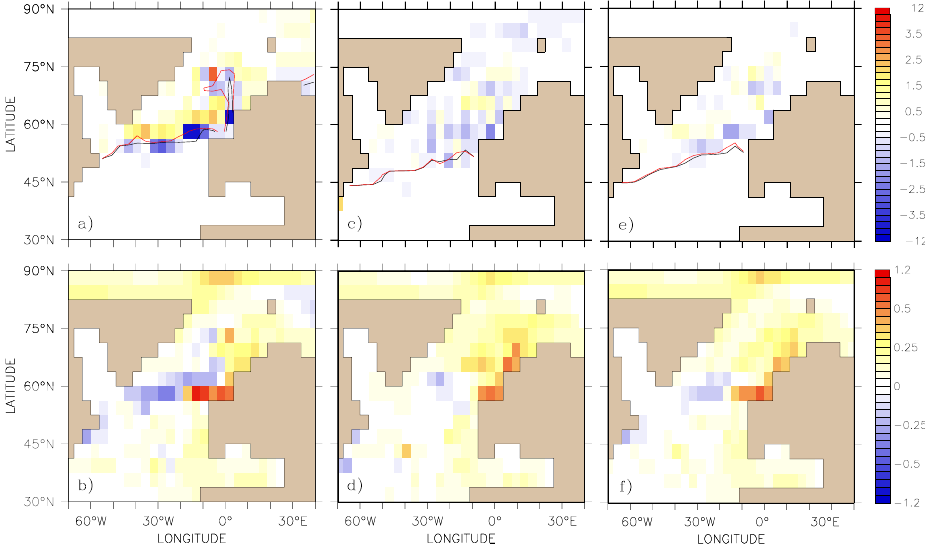
Fig. 5. Anomalies at the transition stage relative to the stadial regime under CO 2 -only forcing conditions of (a) surface freshwater fluxes in myr − 1 and (b) surface salinity during summer months (June–August) in PSU; (c–d) and (e–f) same fields during winter (January–February) and for the annual mean, respectively. Black and red lines show the locations of the 90% northern average sea ice concentration for the stadial and the transition stage,